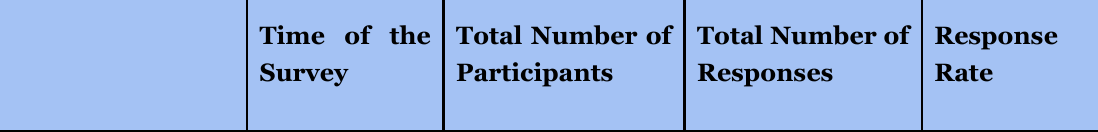
Response Rate for MOOC-Surveys Time of